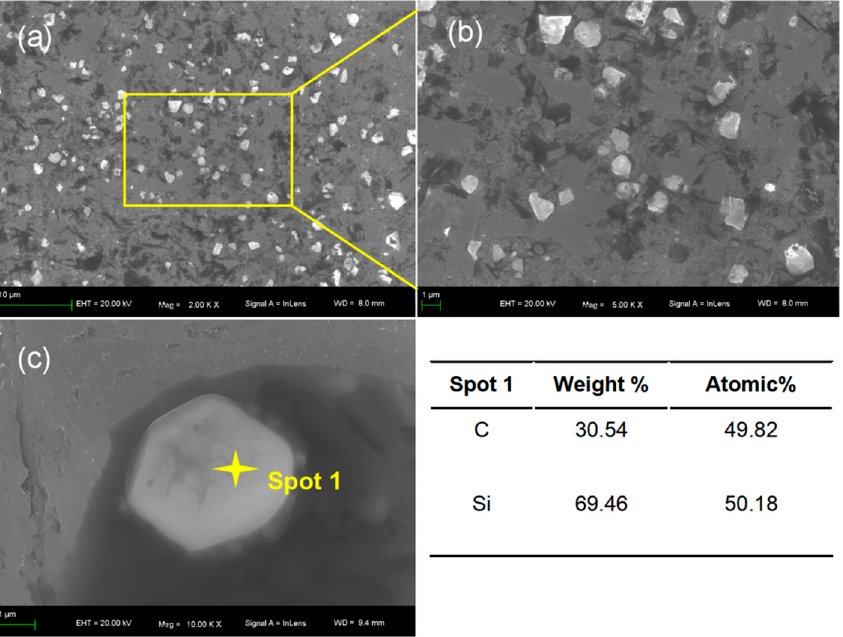
Figure 4. SEM images and EDS point scan analysis ofAl-28Si-7C(G1): ( a ) SEM image, ( b ) SEM image, and ( c ) SEM image of Al-28Si-7C(G1) and EDS point scan analysis.